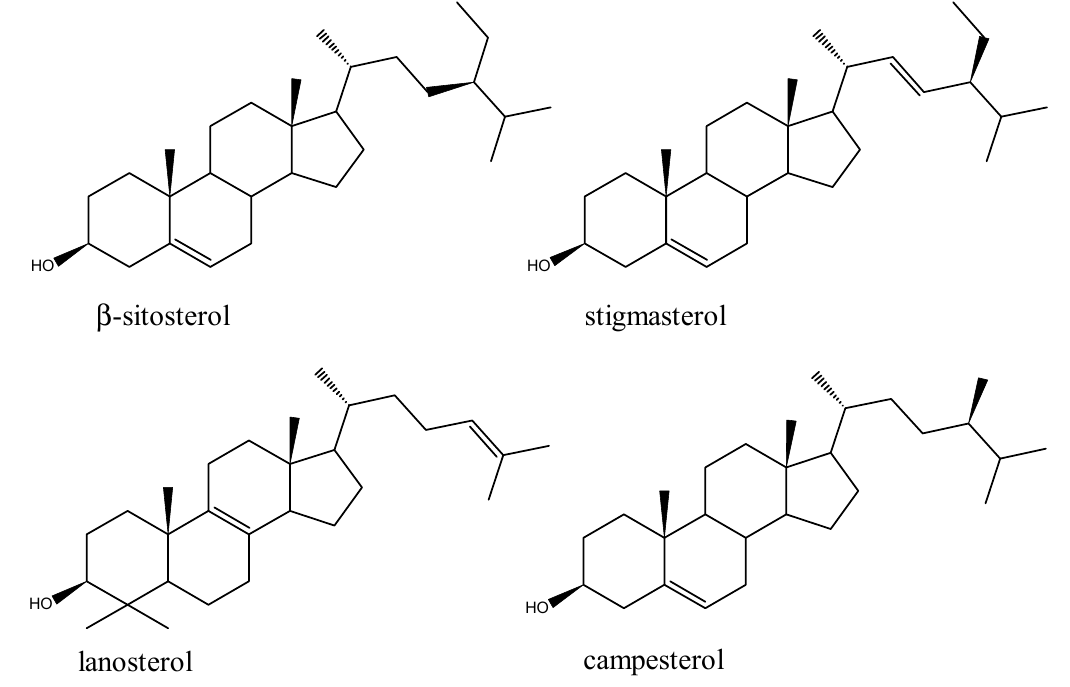
Figure 7. Structures of phenolic acids in Allium spp.